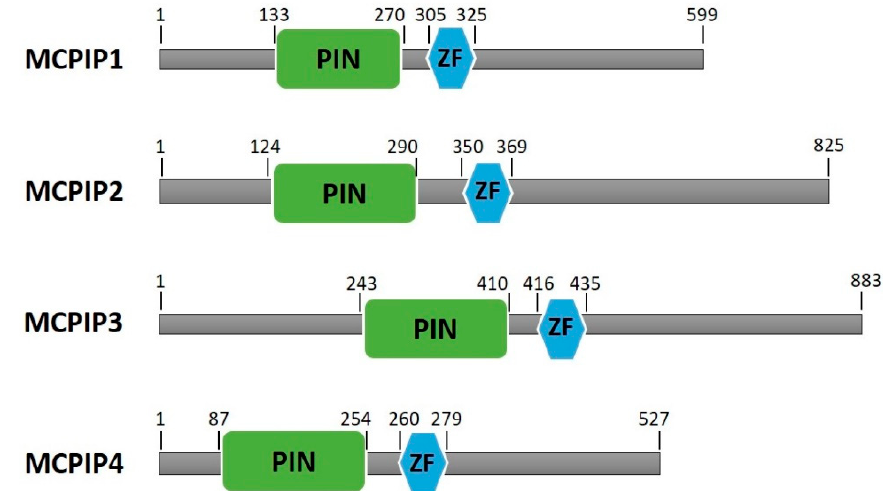
Figure 1. Schematic representation of human MCPIP family members containing the PinT N-terminus domain (PIN) and CCCH-type zinc finger domain (ZF). Based on Lin et al., 2013[22].